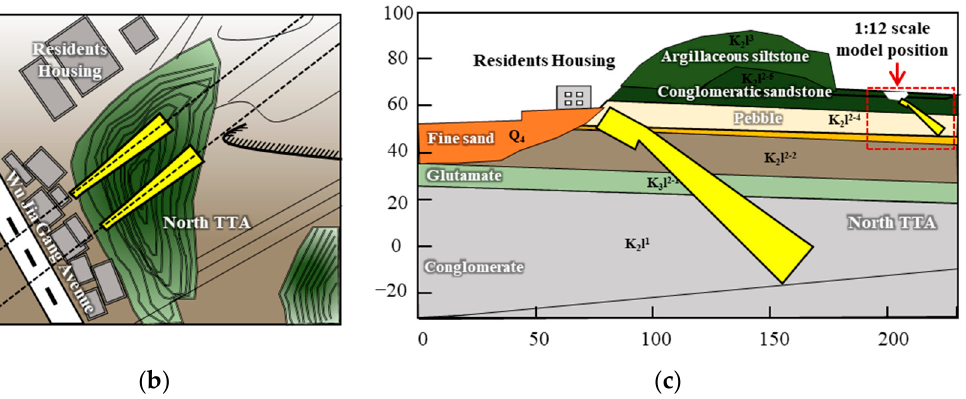
Figure 1. Schematic diagram of tunnel anchorage project on the north side of Wujiagang Bridge: ( a ) project location; ( b ) layout plan; ( c ) the profile.